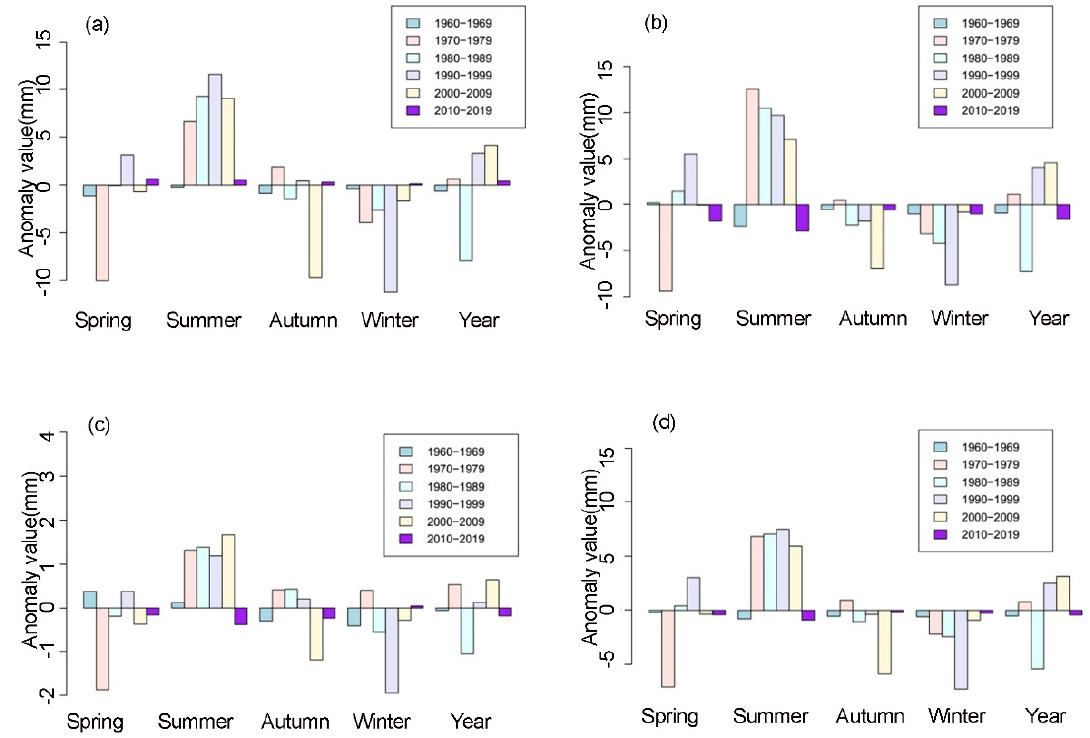
Figure 5. Seasonal and annual precipitation anomaly for different time scales in the Turpan